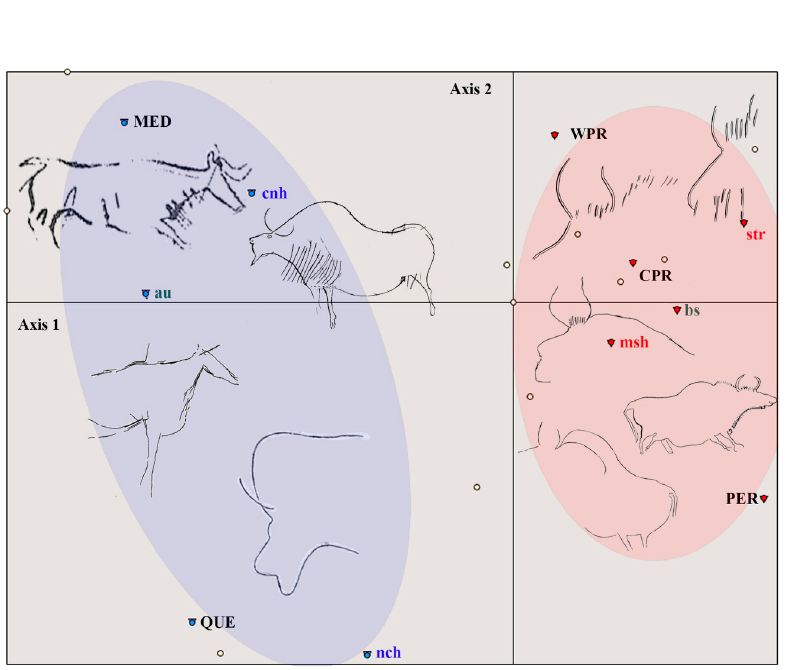
Fig 15. FCA multivariate plot of the studied corpus of 11x11 criteria in the main factorial plane [1,2]. The two- colored groups are generated by ascending hierarchical clustering (MED: Mediterranean, QUE: Quercy, PER: Perigord, CPR: Central Pyrenees, WPR: Western